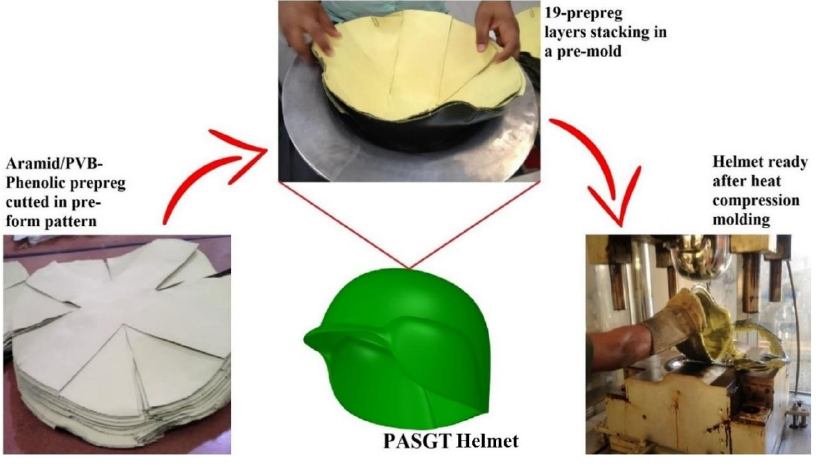
Figure 1. Thermoset ballistic helmet production process.